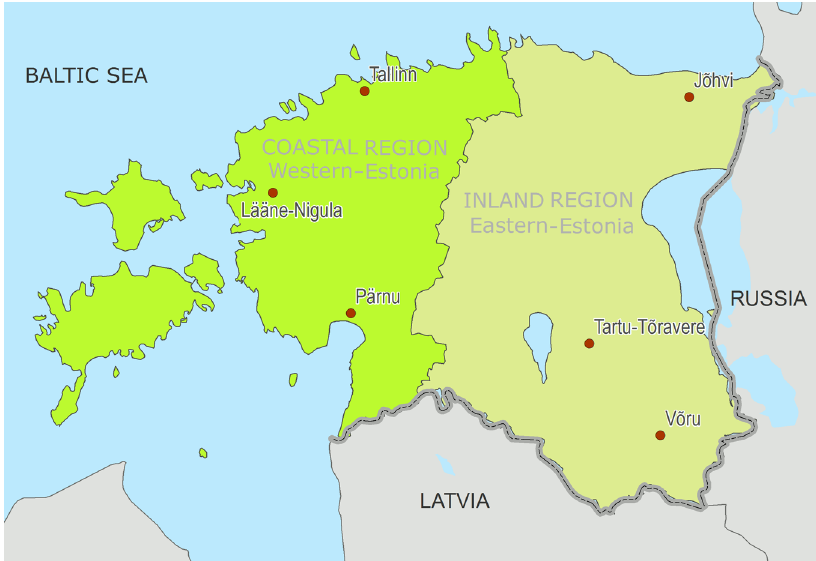
Fig 1. The coastal and inland regions of Estonia, with the meteorological stations used in the current